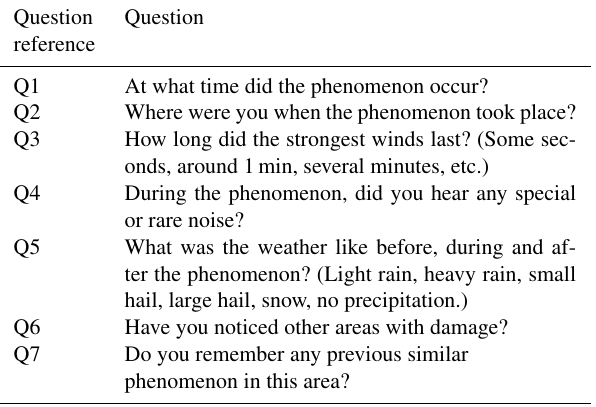
Table 3. Witness questionnaire (reference and